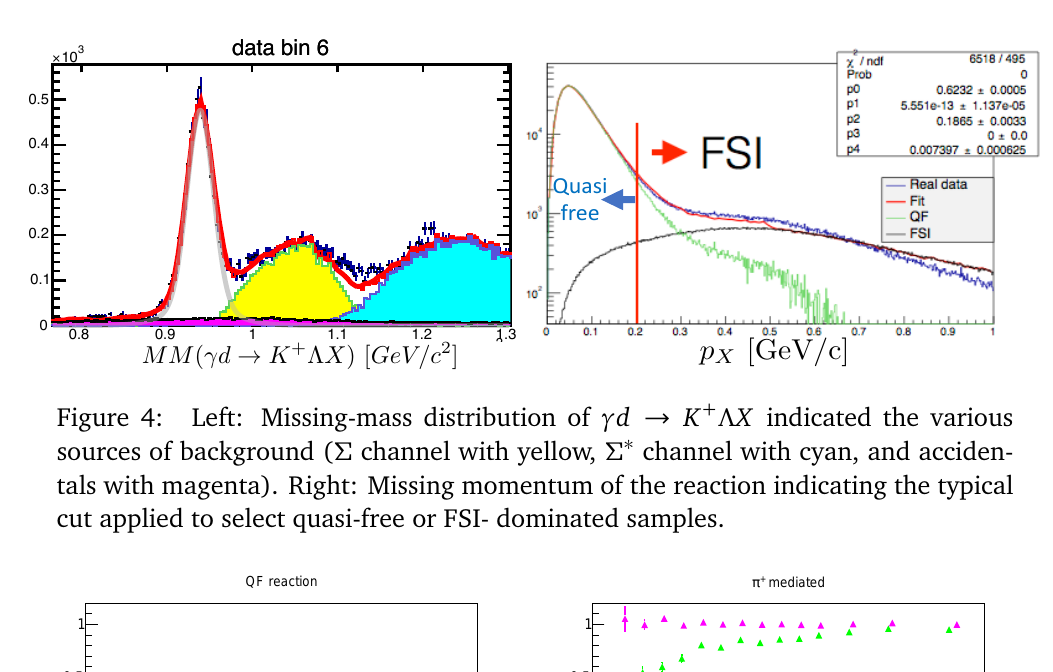
Figure 3. Reaction plane definition for  d ! K + ⇤ n . The upper left panel shows the definition Figure 2. Top panel: Missing-mass distribution of the Figure 10: Fits on missing-mass for each photon-energy bins to determine the ratios r B and r A i i of the kaon azimuthal angle  in which ⌃ produces K + ⇤ X fitted with contributions from reaction  d ! a modulation (see Eq. [1]). The lower left panel  d K + ⌃ 0 X (green),  d K + ⌃ X (purple), and ac- ⇤ ! ! shows the definition of ✓ (and correspondingly ✓ ) cidental events (magenta) from simulated data. The ver- z x in which the double-polarization observables pro- tical dotted lines indicate the cuts that select the events duce modulations. The main figure defines the of interest and the fits are used to perform background kaon laboratory polar angle ✓ , and the hyperon subtraction. Bottom panel: Missing momentum of the re- K + angle ✓ , which is in respect to an axis pointing K + ⇤ X indicating the cut applied to select action  d 0 ⇤ ! along the momentum of the YN pair. FSI. Figure 5: Beam spin asymmetries as a function of the neutron momentum of gener- ated data for the four mechanisms that contribute to the reaction γ d → K + Λ n . The different points show the asymmetries determined using the azimuthal distribution of the various particles as indicated in each